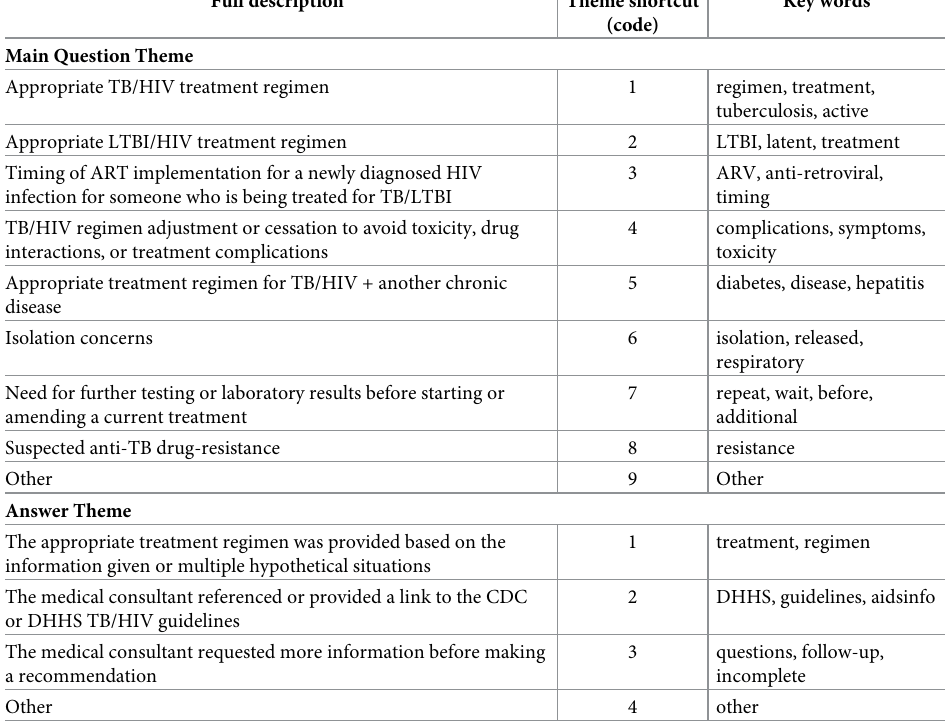
Table 2. Example of